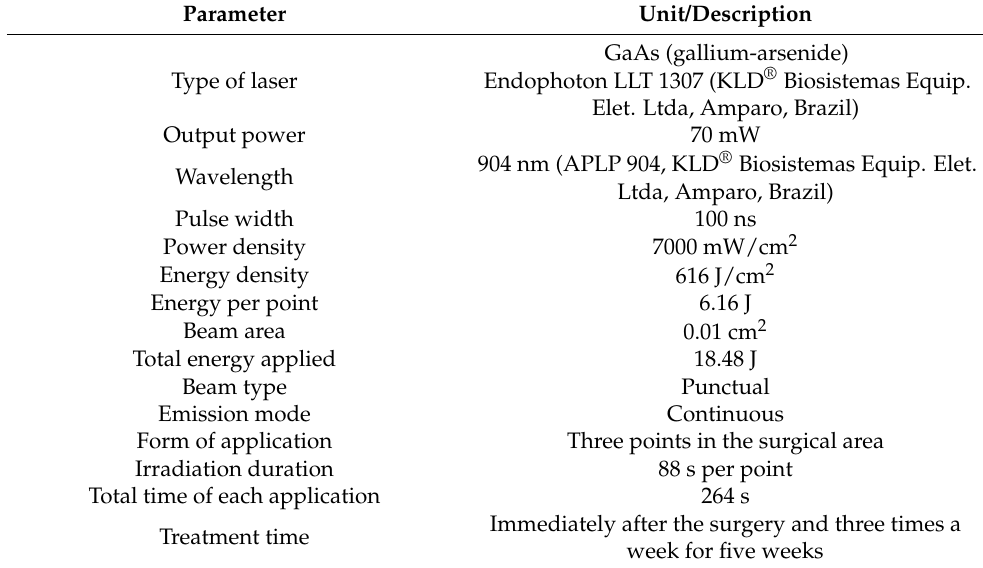
Table 1. Photobiomodulation